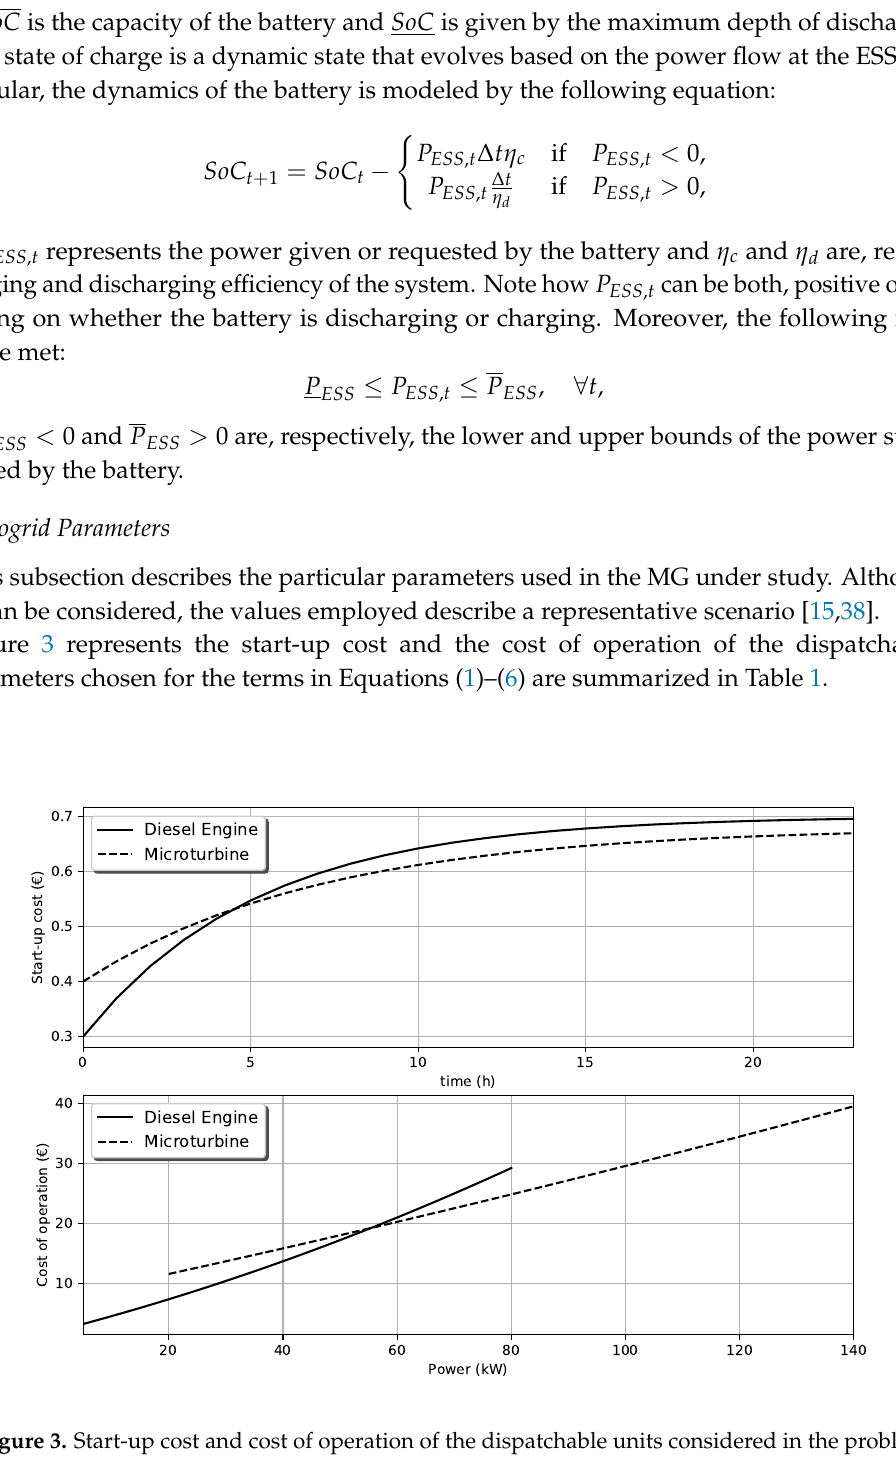
Figure 3. Start-up cost and cost of operation of the dispatchable units considered in the